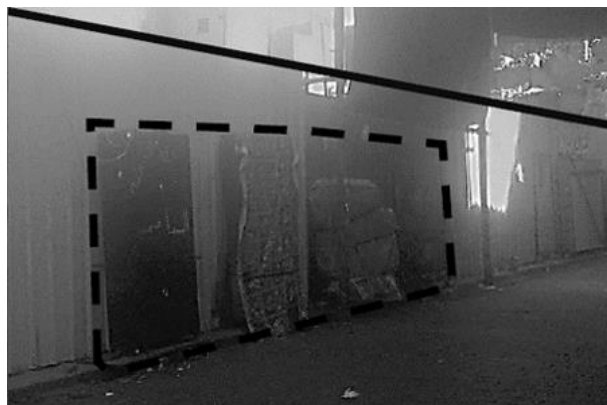
Figure 21. Vendors storing the